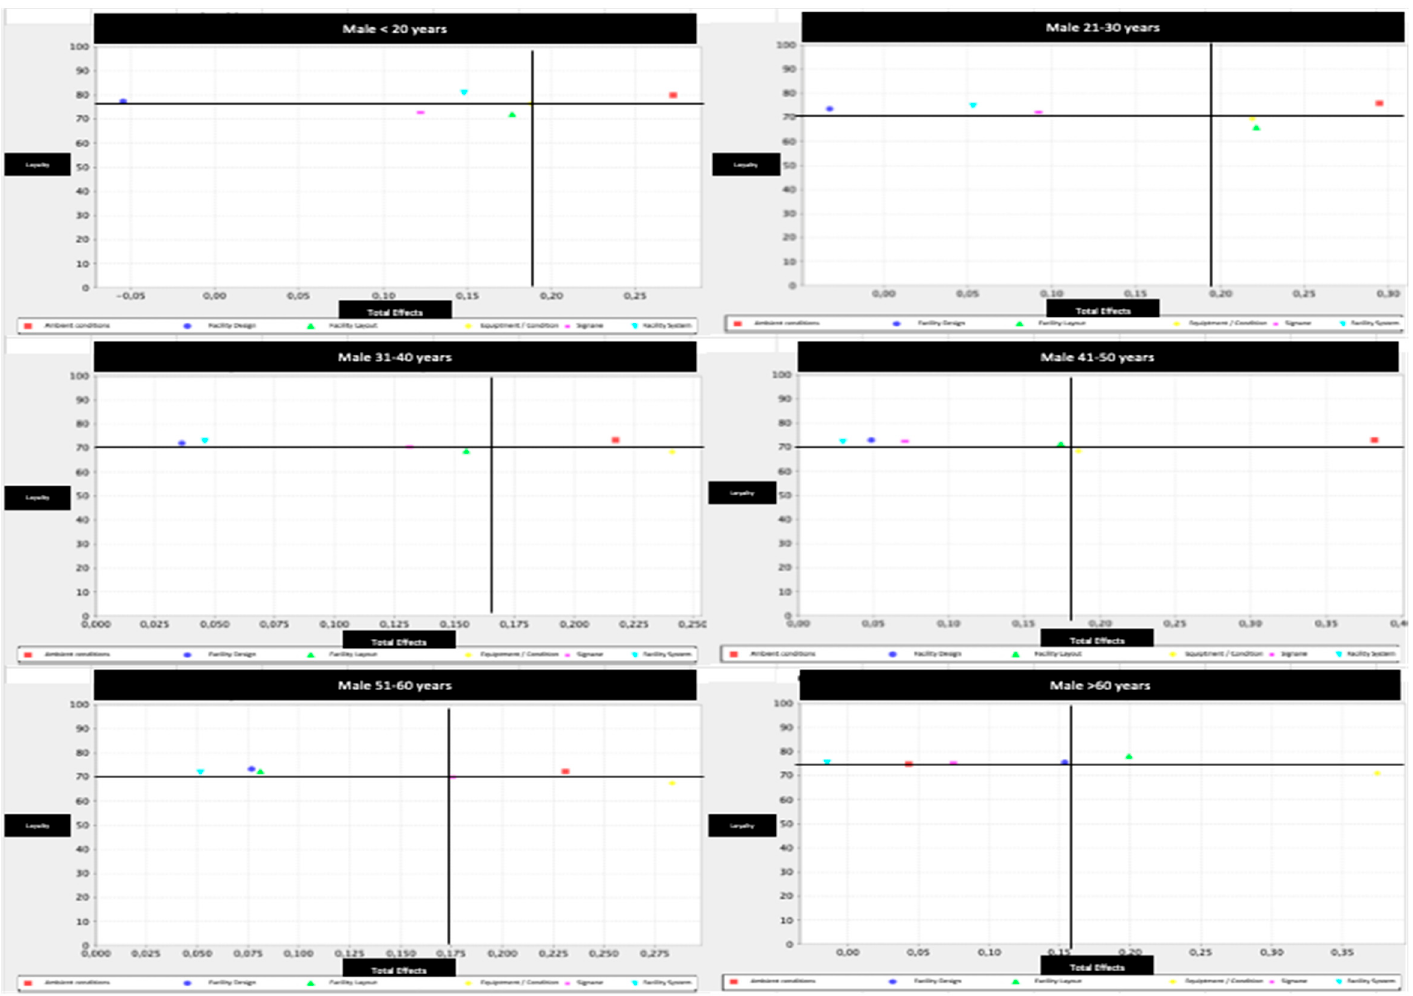
Figure 5. Importance-performance map by male and age group. Note: Red: ambient condition; Strong blue: facility design; Green: facility layout; Yellow: equipment/facility condition; Pink: signage; Light blue: facility system.